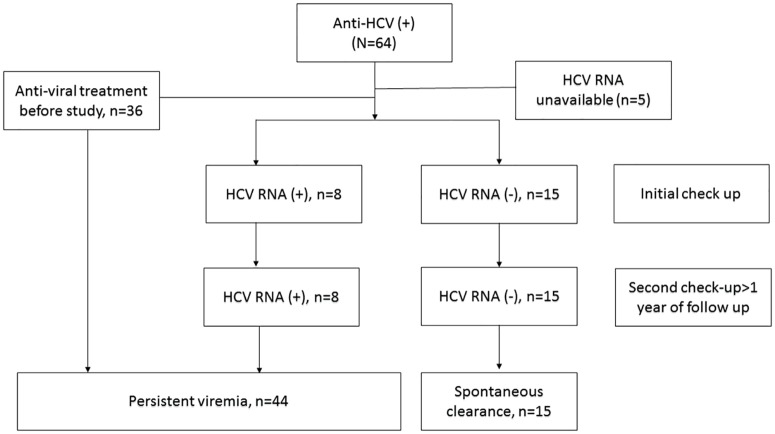
Flow chart of the patients with anti-HCV seropositivity.